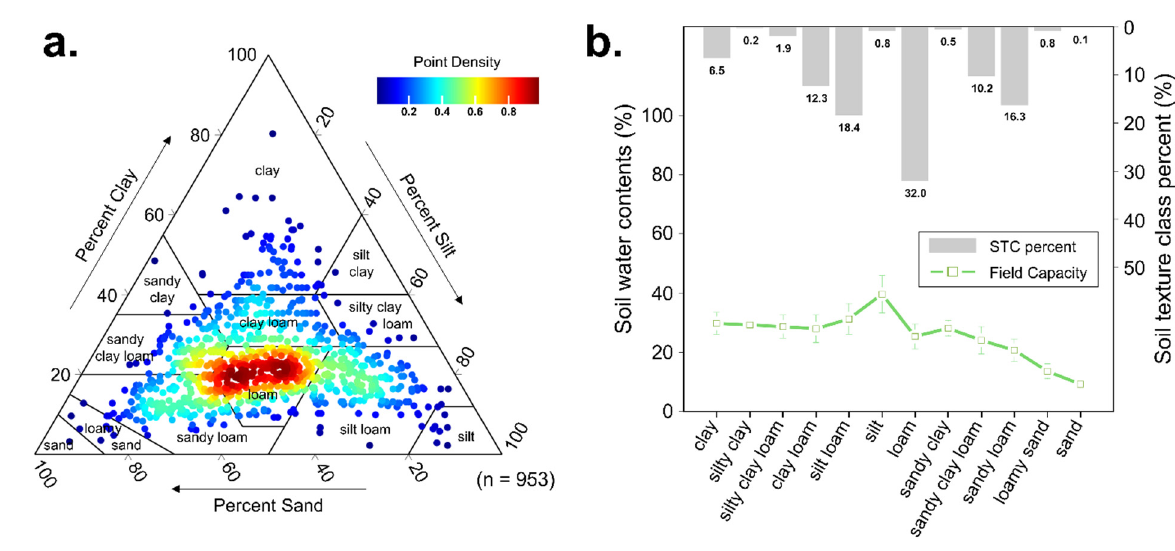
Figure 2. ( a ) Distribution of forest soils used in this study (953 soil samples) across USDA textural classes and ( b ) mean values and standard deviations of FC and soil texture class (STC) percentages.